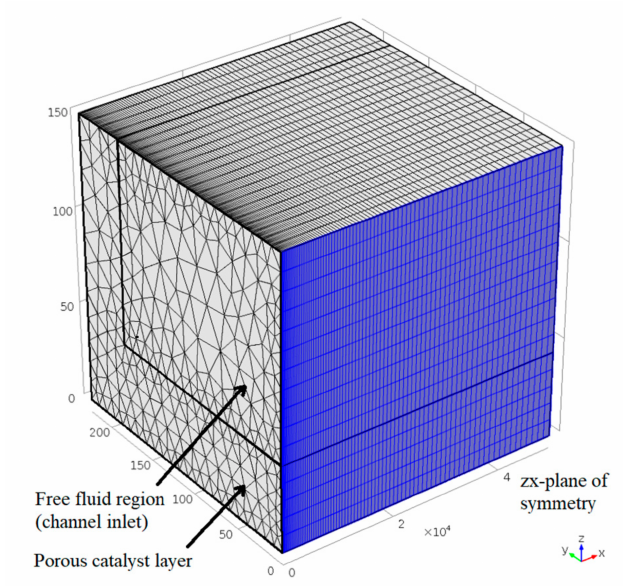
Figure 3. Discretised model geometry, illustrating the microchannel’s free fluid and porous catalyst regions, and the central longitudinal plane of symmetry (axes in µ m). Adapted with permission from S. Chiuta, R.C. Everson, H.W.J.P. Neomagus, L.A. Le Grange, D.G. Bessarabov, International Journal of Hydrogen Energy; published by Elsevier, 2014